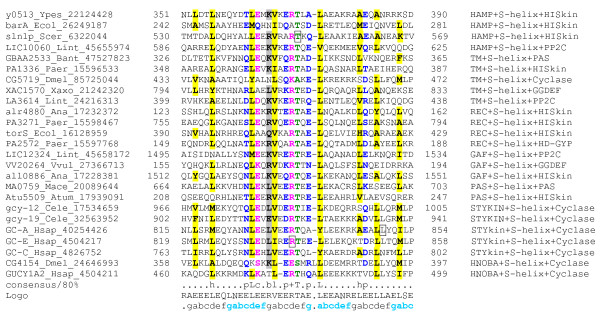
Multiple alignment of representative examples of the S-helix. Representatives from a multiple alignment of the S-Helix domain, generated using the MUSCLE program [49] and corrected using PSI-BLAST [47] search results, are shown. The logo and the heptad notations are shown. The 80% consensus shown below the alignment was derived from an alignment of all the members using the following amino acid classes: consensus from the logo is also shown and colored using the following amino acid classes: hydrophobic (h: ACFILMVWY, yellow shading); aliphatic subset of the hydrophobic class (l; ILV, yellow shading); the aromatic subset of the hydrophobic class (a; FHWY, yellow shading); small (s: ACDGNPSTV, green); the tiny subclass of small (u; GAS, Green shading); polar (p: CDEHKNQRST, blue); the charged subclass of polar (c: DEHKR, pink); the positive subclass of charged (+: HKR, pink); the negative subclass of charged (-: DE, pink); alcohol (o: ST, Blue); and big (b: KFILMQRWYE, grey). A 'L', or 'T' show the completely conserved amino acid in that group. The limits of the domains are indicated by the residue positions, on each side. The domain architecture is shown to the right. The domain abbreviations are as in section 2 Materials and Methods and legend to Fig. 4. The mutations discussed in the paper are marked with boxes. The sequences are denoted by their gene name followed by the species abbreviation and GeneBank Identifier. The species abbreviations are: Ana: Nostoc sp.; Atum: Agrobacterium tumefaciens; Bant: Bacillus anthracis; Cele: Caenorhabditis elegans; Dmel: Drosophila melanogaster; Ecol: Escherichia coli; Hsap: Homo sapiens; Iloi: Idiomarina loihiensis; Lint: Leptospira interrogans; Mace: Methanosarcina acetivorans; Paer: Pseudomonas aeruginosa; Scer: Saccharomyces cerevisiae; Vvul: Vibrio vulnificus; Xaxo: Xanthomonas axonopodis; Ypes: Yersinia pestis